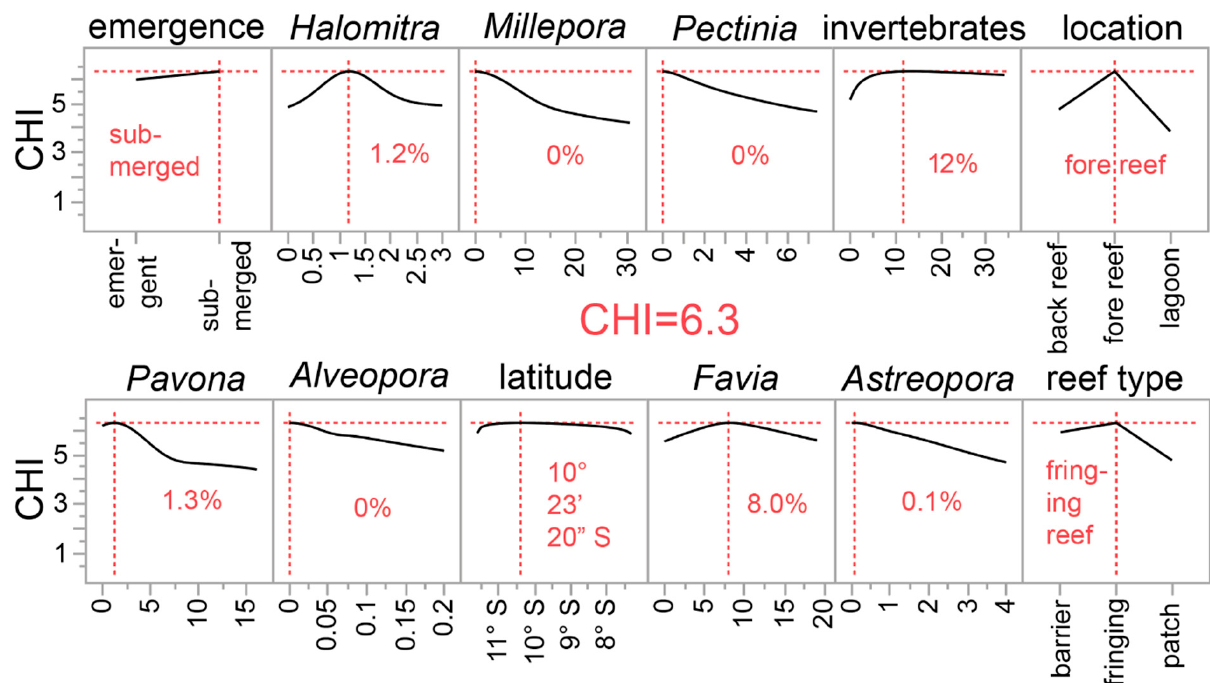
Figure 5. A desirability analysis derived from a neural network for predicting the coral health index (CHI) from both 11 environmental (ENV) parameters and 50 benthic surveys (ECO) parameters. Since the neural network was so complex (TanH(4)-Linear(2)-Gaussian(3)-Boost(8) with covariates transformed [single hidden player]), the Python script needed to reproduce it is shown in the online supplemental data file with a crude, low-resolution approximation showing the underlying structure (Supplementary File 2). Ten percent of coral samples were randomly excluded from the model and then used as validation samples (validation R 2 = 0.82 and mean absolute deviation = 0.33). The highest plotted values in each of the sub-panels represent the condition in which the CHI was maximized; only the 12 most influential predictors have been shown (based on a dependent resampled inputs algorithm), and they are presented in order of model influence, from most (top-left) to least (bottom-right) important. Note that the maximum CHI of 6.3 is technically beyond the highest value of this parameter (Figure 1).